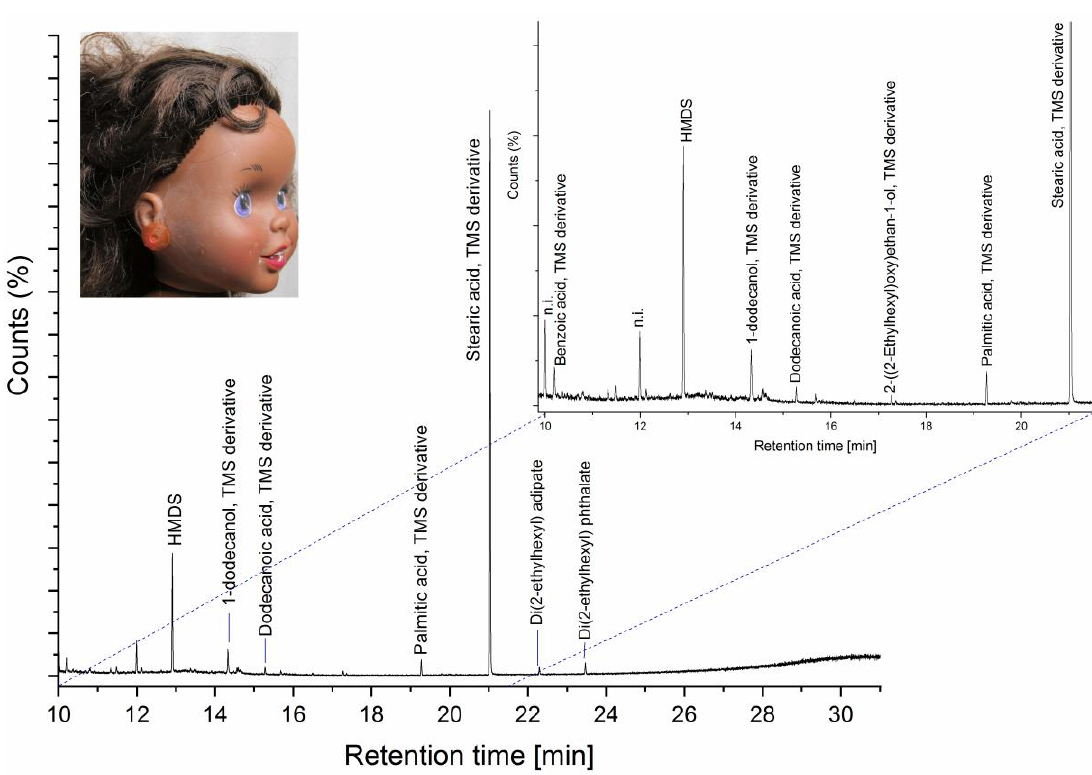
Figure 9. Detail of the PVC head of doll E4 showing a white surface bloom (image insert, ©Tate.) and HMDS-PyGCMS pyrogram of a sample of the white bloom. The TMS derivative of stearic acid dominated the sample, and small amounts of the TMS derivatives of 1-dodecanol, dodecanoic acid, palmitic acid were also identified, along with traces of di(2-ethylhexyl)adipate (DEHA) and di(2-ethylhexyl) phthalate (DEHP).